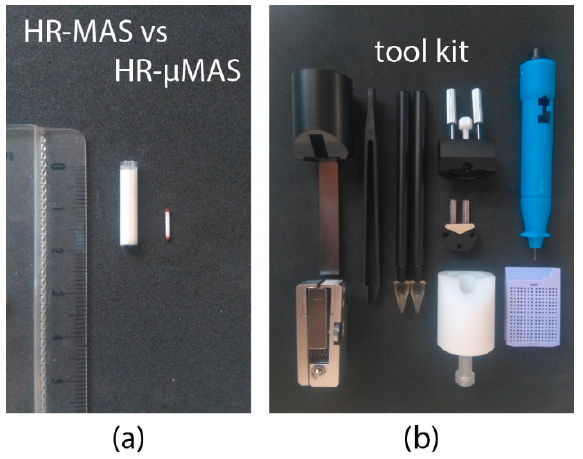
Figure 4. ( a ) MAS rotor comparison between 4-mm HR-MAS and 1-mm HR-µMAS. ( b ) A typical toolkit for the sample-preparation of an HR-µMAS experiment.